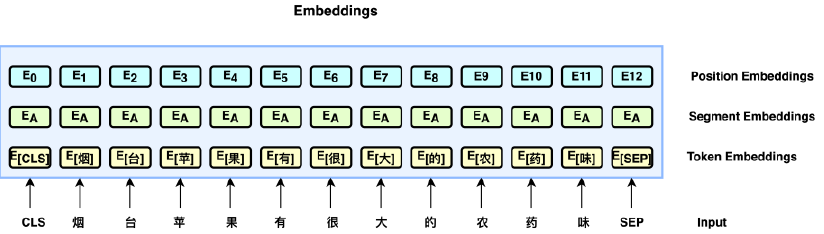
Figure 3. ERNIE embedding layer. ERNIE represents sentence as Embeddings constructed by summing Token Embeddings, Segment Embeddings and Position Embeddings through the embedding layer.